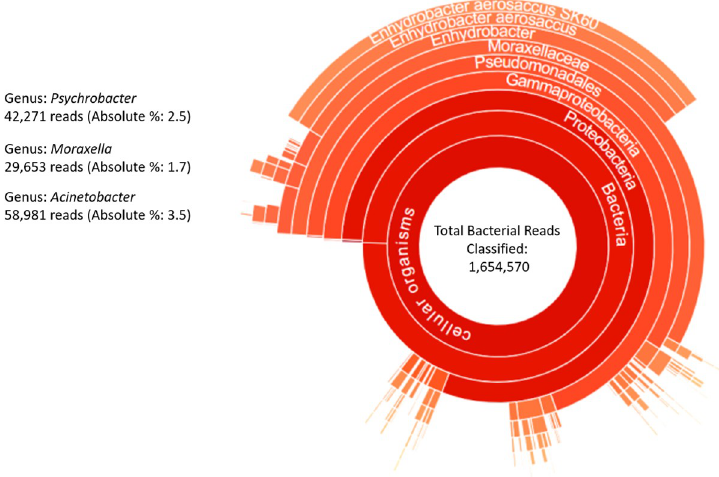
Fig 4. Taxonomer bacterial composition classifier sunburst of isolate NA45737. Reads are classified against 16S sequences and protein sequences from Uniref50. The size of a given sector represents the relative abundance at the read level. Taxonomic ranks are hierarchical with the highest level placed in the center. Reads not classified at the species level, either because they are shared between taxa or represent novel microorganisms, are collapsed to the lowest common ancestor and shown as part of slices that terminate at higher taxonomic ranks (e.g.